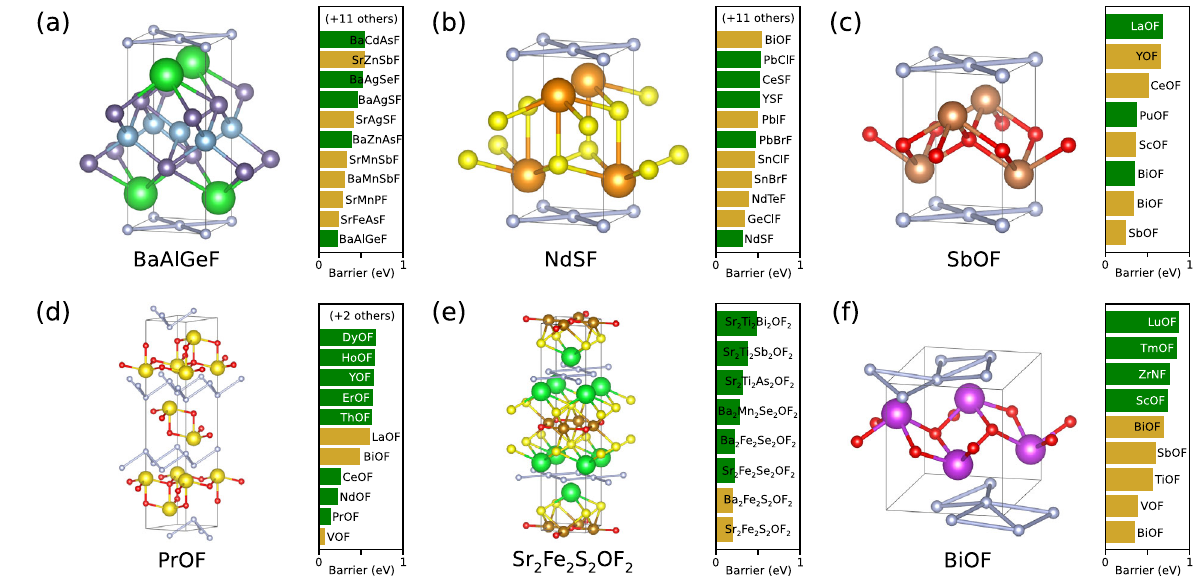
Fig. 5 Structure types for fl uoride intercalation in layered materials. These six structure types contain at least three stable compositions (E hull = 0 eV), each with a predicted pathway barrier between 0 and 1 eV. Each structure type shows an example crystal structure and its composition. The corresponding bar charts show barriers of compositions with the same structure. Compositions labeled by a green bar are thermodynamically stable, while gold is metastable according to the Material Project database 40